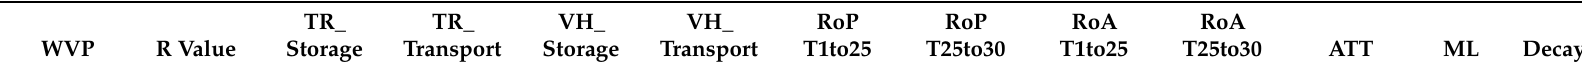
Table 4. Pearson correlation analysis evaluating by material properties, transpiration rate, vital heat, air and pulp temperatures and okra